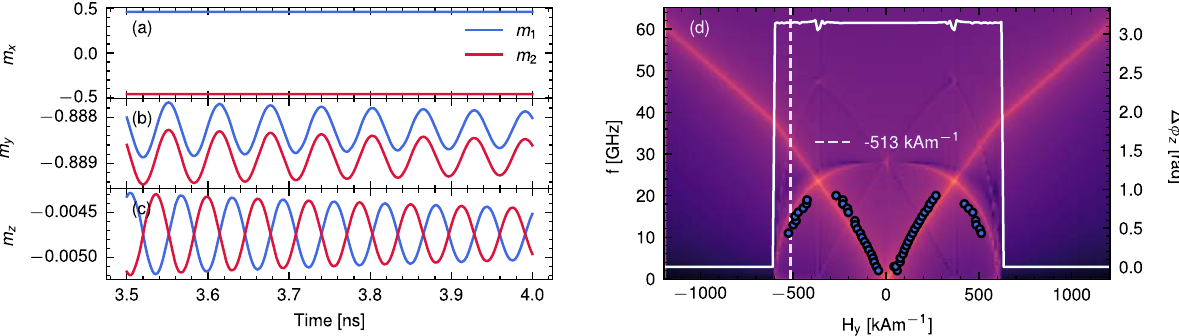
Fig. 3 Co(4 nm)/Ru(0.65 nm)/Co(4 nm) system with both linear and quadratic components of the IEC. a – c magnetisation trajectory components for a H ext = 513 kA m − 1 , marked with the dashed white line in ( d ). Colour denotes a layer, blue for the top and red for the bottom layer. c Shows that the m z components of the two layers oscillate in antiphase. d Kittel dispersion relation obtained from PIMM (described in the section “ Spin valve dynamics ” ), with experimental points from SD-FMR (given by blue dots), and phase difference Δ ϕ z between m z components of two layers (solid white line) across the external magnetic fi eld range. The region between approximately − 600 and 600 kA m − 1 , where the optical branch is visible, exhibits antiphase oscillation of m z components. Parameters are taken from Supplementary